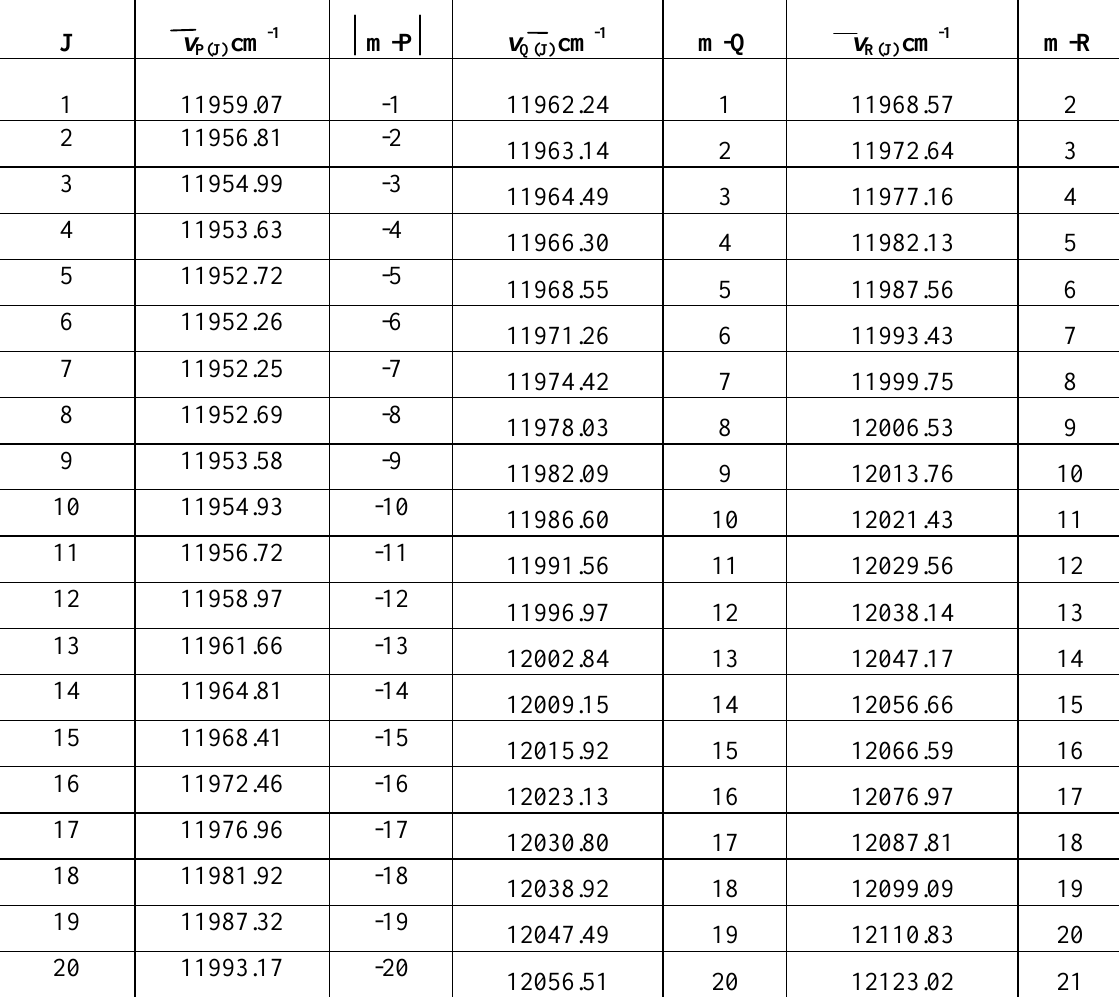
Table 6: Values of wave numbers for P,Q and R branch for B 1 Σ + - A 1 Π